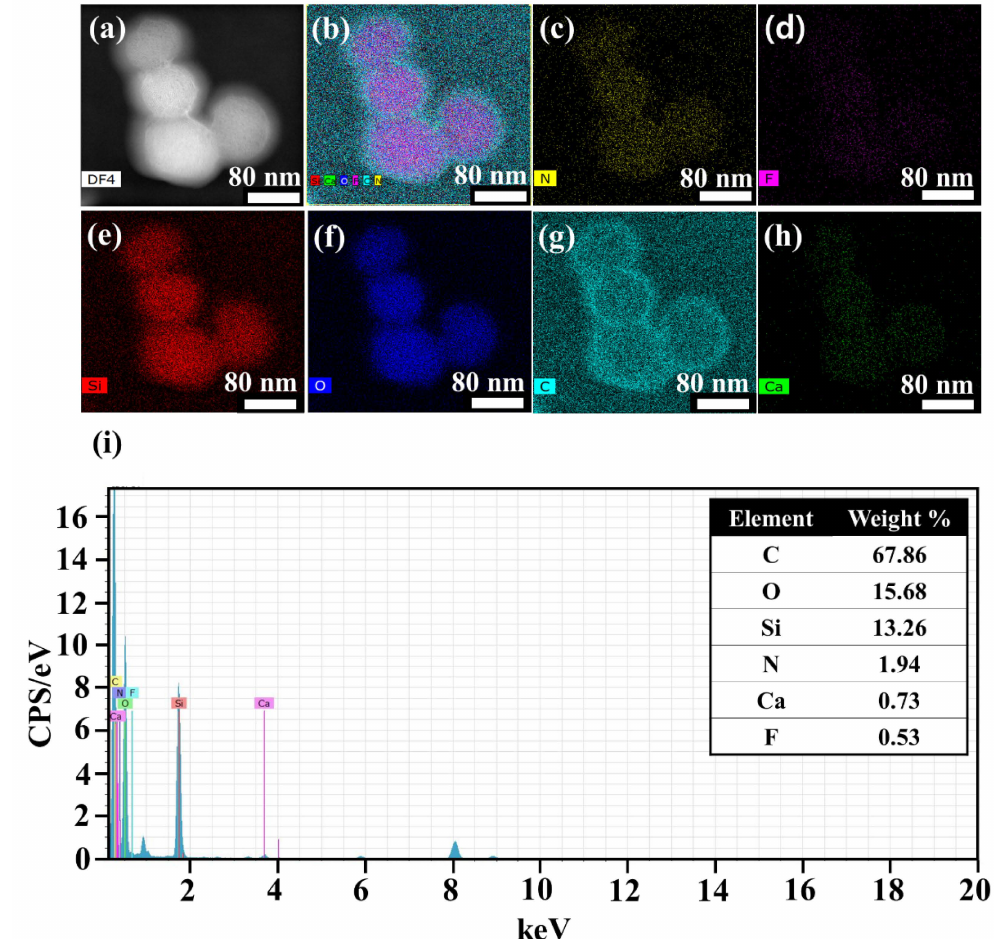
Figure 3. FE-TEM image ( a ), EDS mapping ( b – h ) and spectra ( i ) of